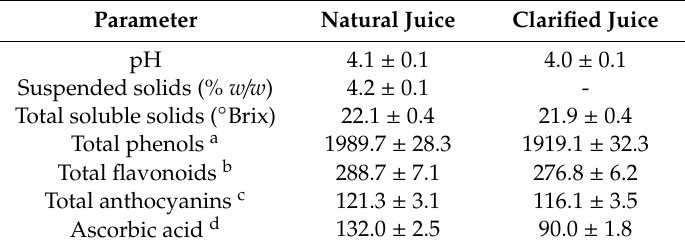
Table 1. Physicochemical properties of untreated (natural) and clarified pomegranate